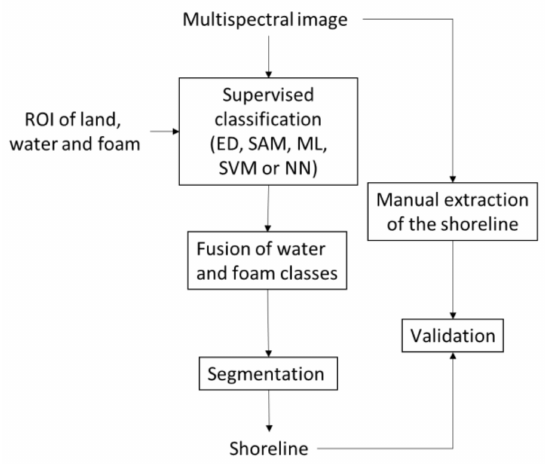
Figure 4. Flowchart of the classification methodology. ROI stands for “Region Of